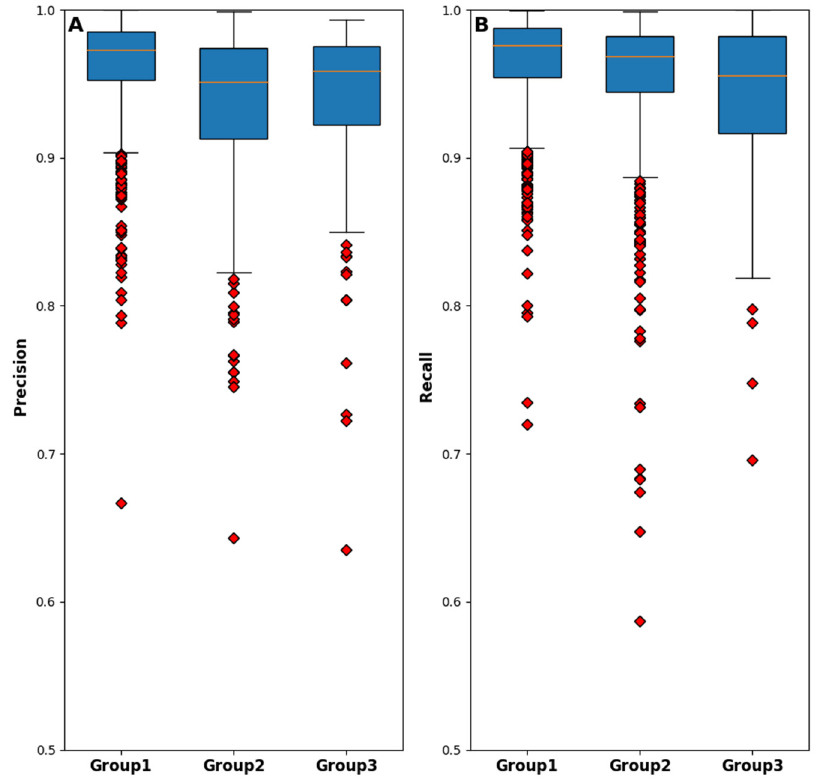
Figure 12. Box plot diagrams of the automatic method performances in terms of ( A ) precision and ( B ) recall metrics, dividing the dataset between the groups.